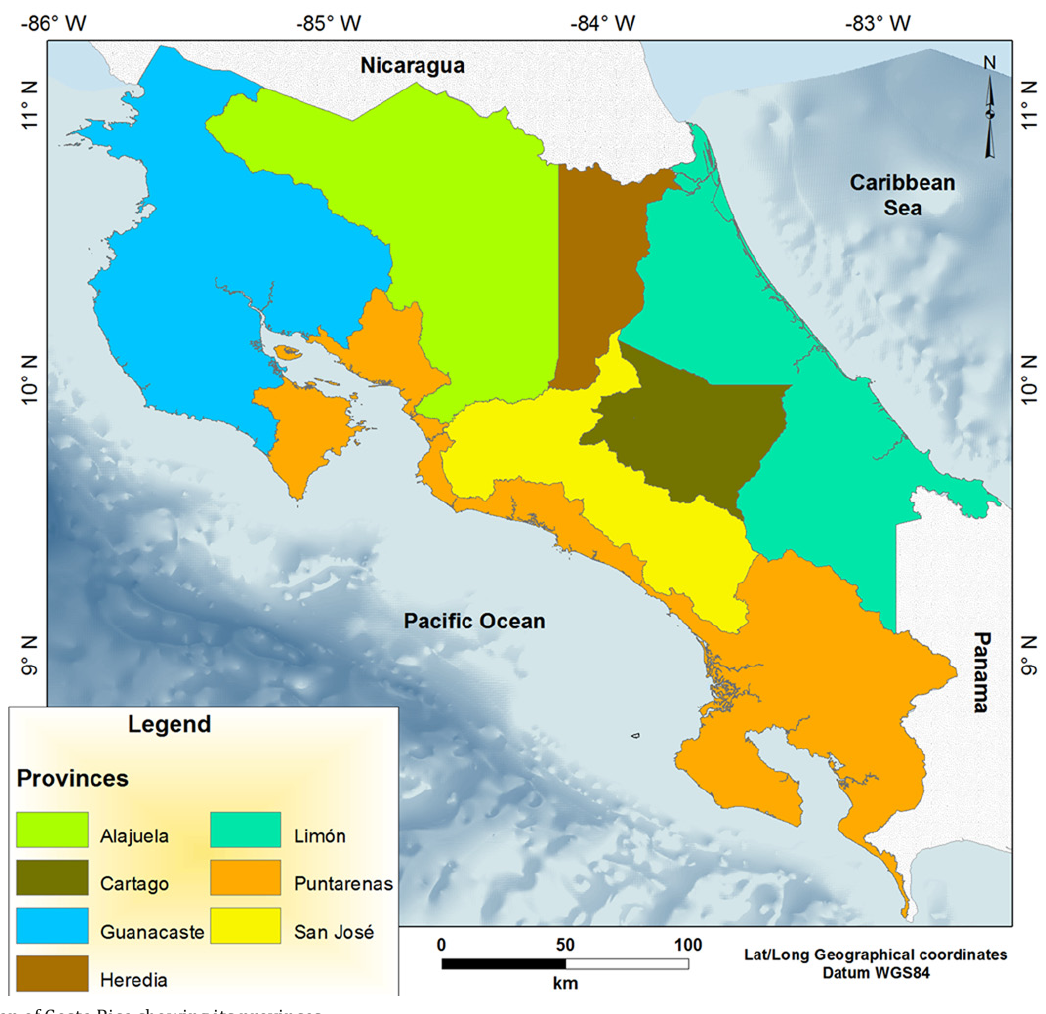
Figure 1 . Map of Costa Rica showing its provinces.